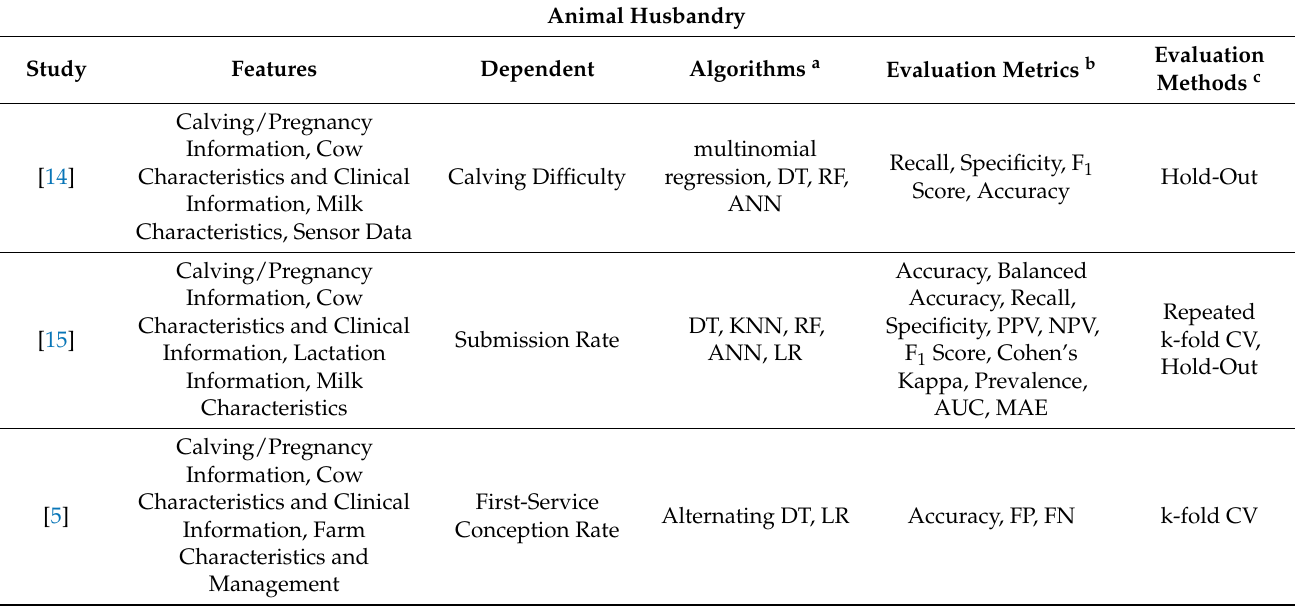
Table A5. Feature data, dependent variables, algorithms, evaluation metrics and methods used per study. Animal